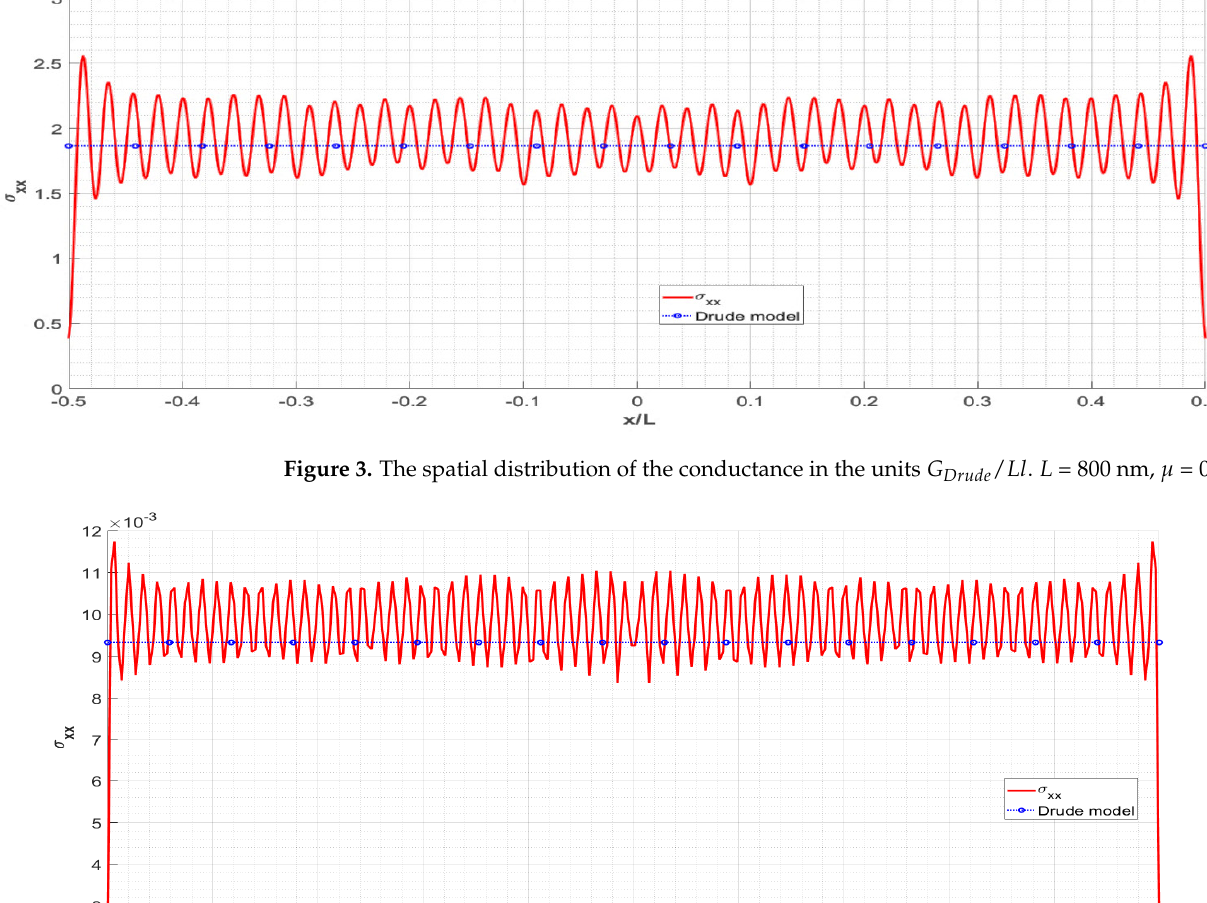
G Ll . L = 800 nm, μ = 0.5 Drude